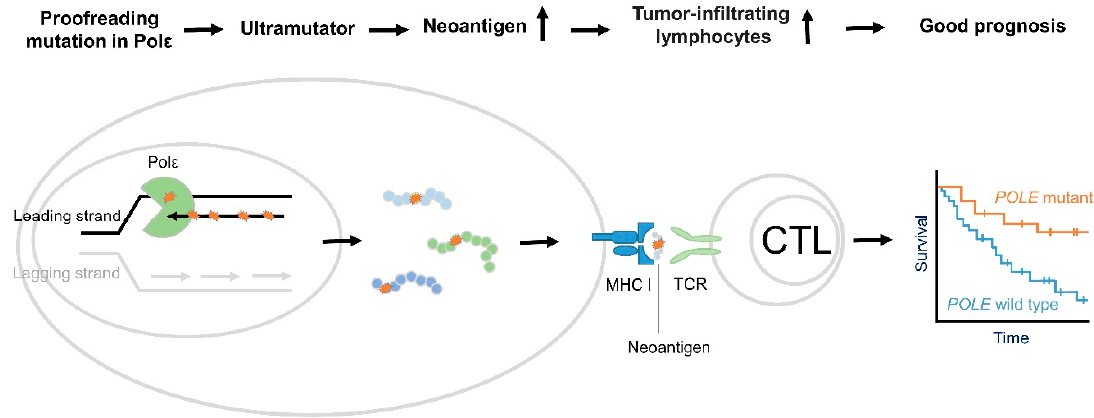
Figure 1. Proposed mechanism of good prognosis in PolE associated